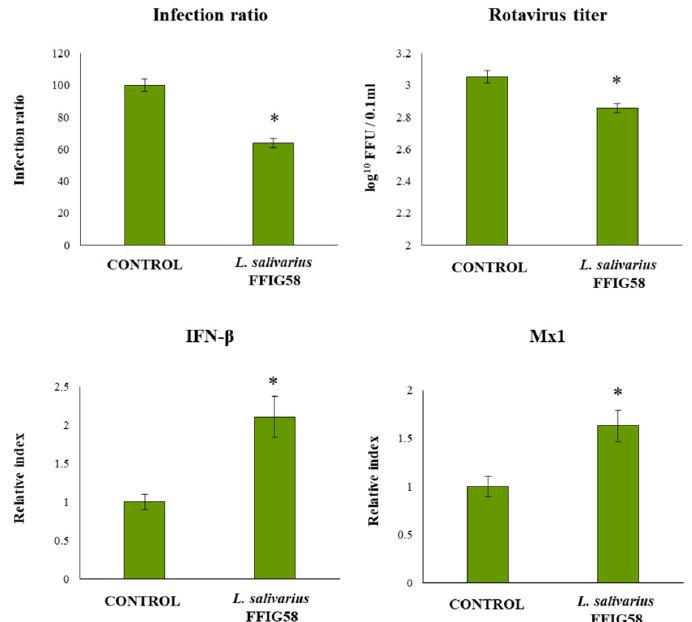
Figure 13. Effect of Ligilactobacillus salivarius FFIG58 on the resistance of porcine intestinal epithelial (PIE) cells to rotavirus infection. PIE cells were stimulated with the FFIG58 strain isolated from wakame-fed pigs then challenged with rotavirus. PIE cells with no lactobacilli treatment and challenged with rotavirus were used for comparisons. Rotavirus infection was evaluated by immunofluorescence assay. The protective ability of lactobacilli was examined by calculating the virus titer and the infection ratio. The results represent data from three independent experiments. Asterisks indicate significant differences when compared to the rotavirus control group (* p < 0.05).